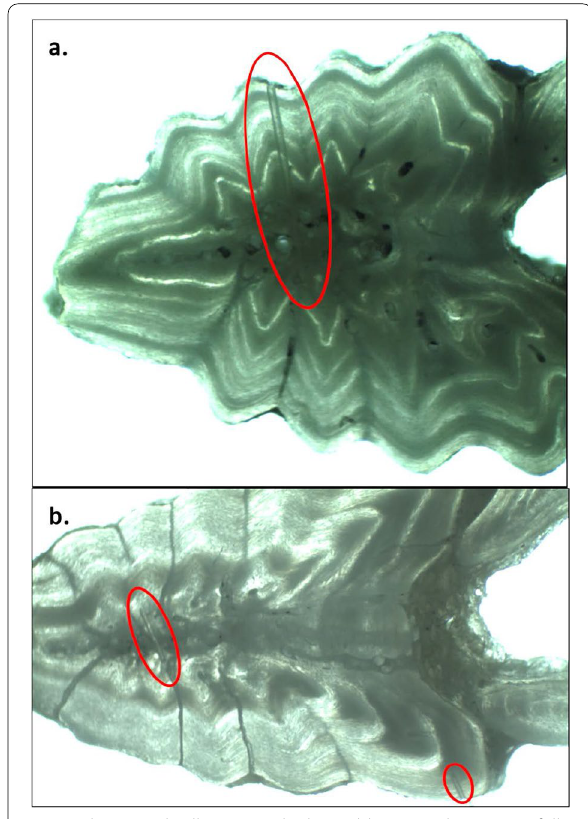
Fig. 2 Photographs illustrating the laser ablation analyses using full “core to edge” transects corresponding to November 2015 ( a ) and smaller separate “core” and “edge” transects corresponding to March 2016 ( b ). Red circles highlight ablation